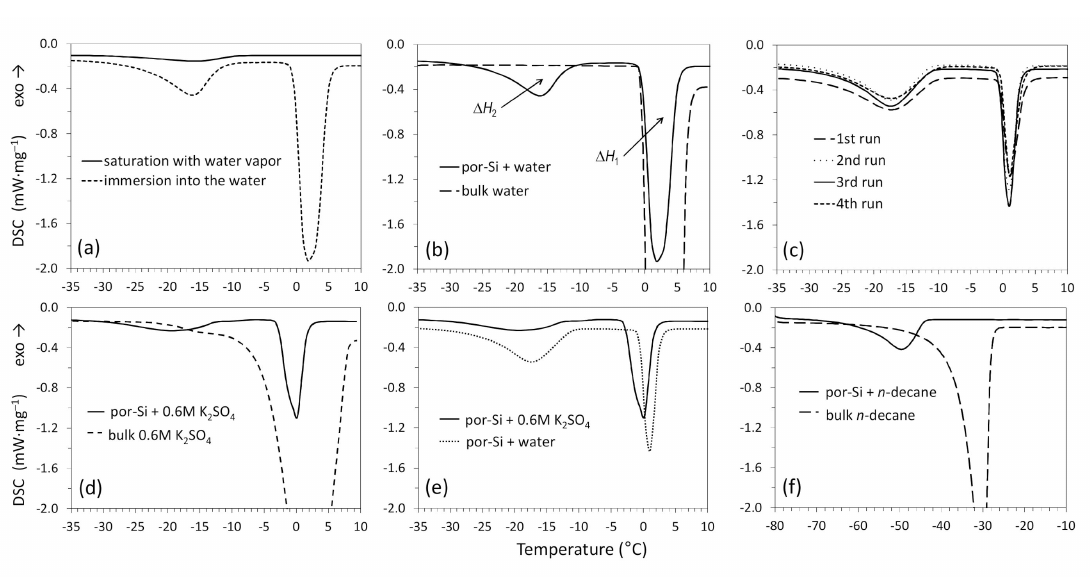
Figure 4. Di ff erential scanning calorimetry (DSC) results: heating scans of the por-Si containing H 2 O ( a – c ); heating scan of the por-Si containing 0.6 M K 2 SO 4 solution ( d ); comparison of scans of the por-Si membranes containing H 2 O and 0.6 M K 2 SO 4 solution ( e ); and heating scan of the por-Si contained n -decane ( f ). Table 1. DSC data on temperatures of extrapolated peak onset ( T onset ) and peak minimum ( T peak ) for melting of nanoparticles inside the pores in comparison with peak minimum temperature for melting of bulk substances. Liquid T onset , K T peak ,